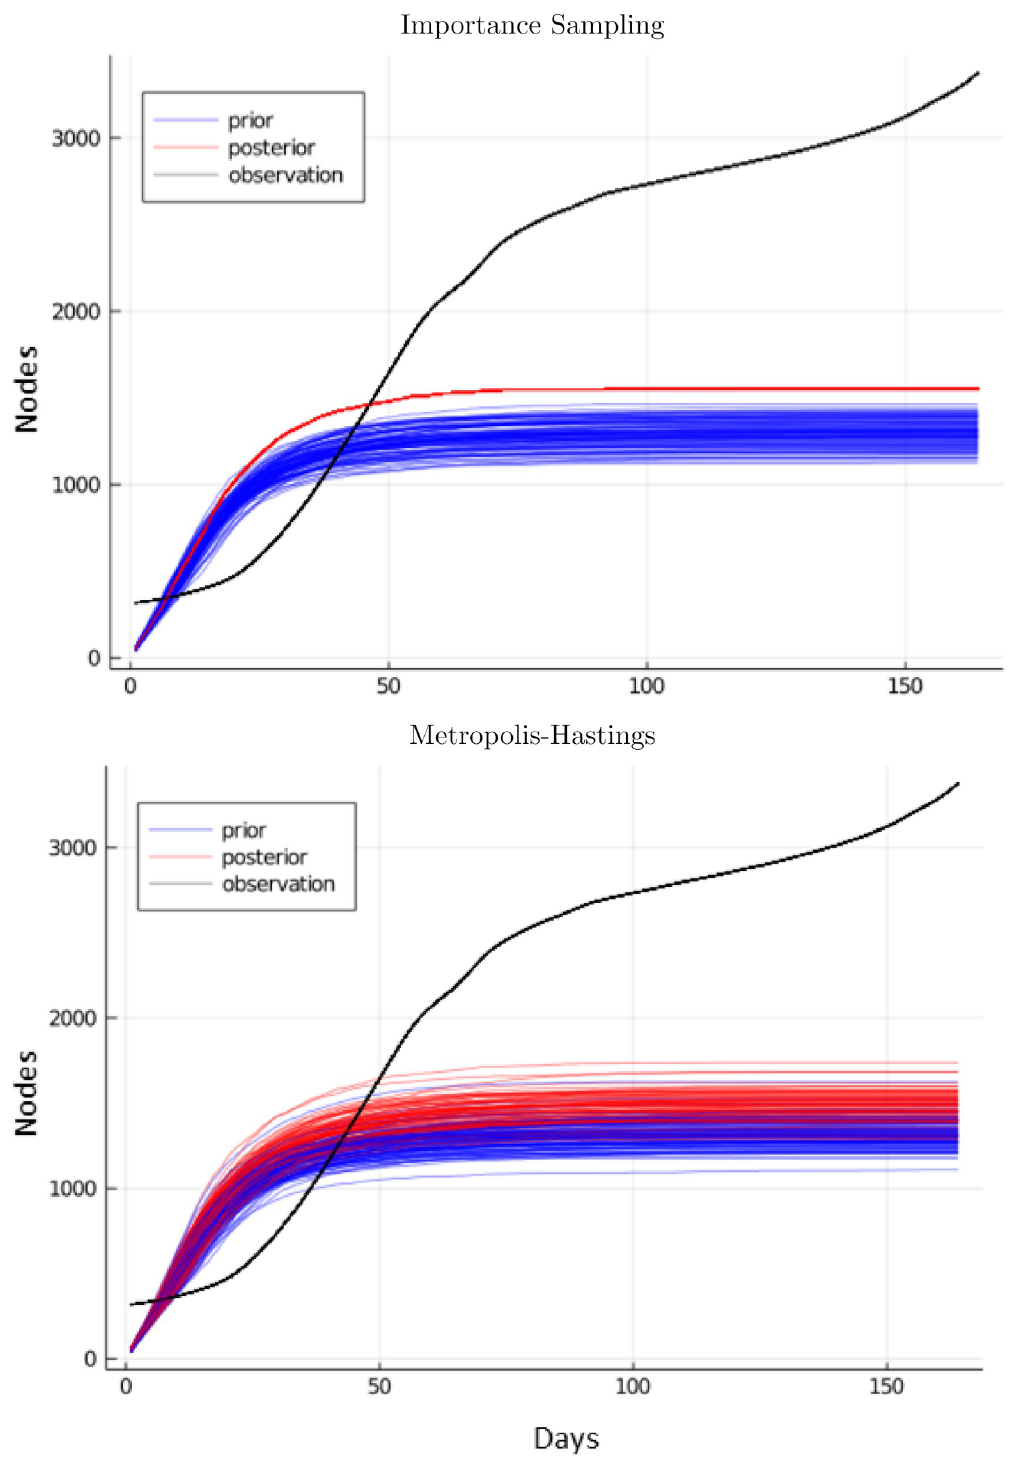
Fig 4. Samples for the NSEIR model for Miami-Dade using parameters learned from likelihood weighting and Metropolis-Hastings. Neither alternate method is able to produce a good fit.